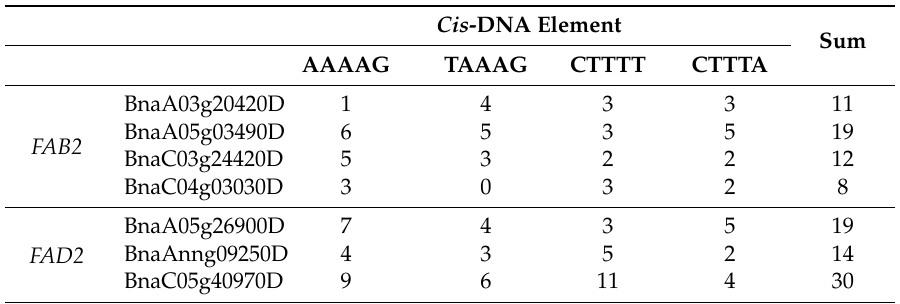
Table 1. Number of transcripts of GmDof regulated genes in seeds at 34 days after flowering (DAF) and the cis -DNA elements of these genes.